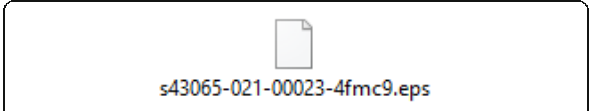
Fig. 9 VOC concentrations of an open green corridor